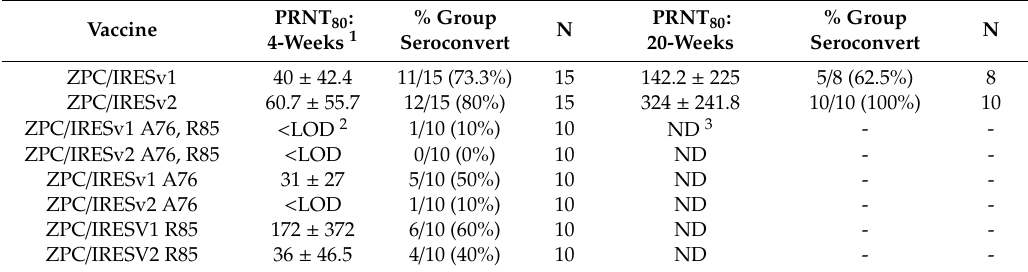
Table 2. PRNT 80 neutralization titers following ZPC / IRES vaccination of mice.